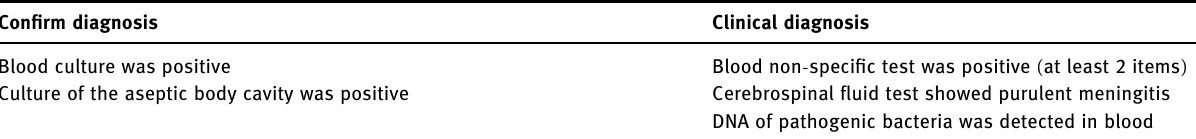
Con fi rm diagnosis Clinical diagnosis Blood culture was